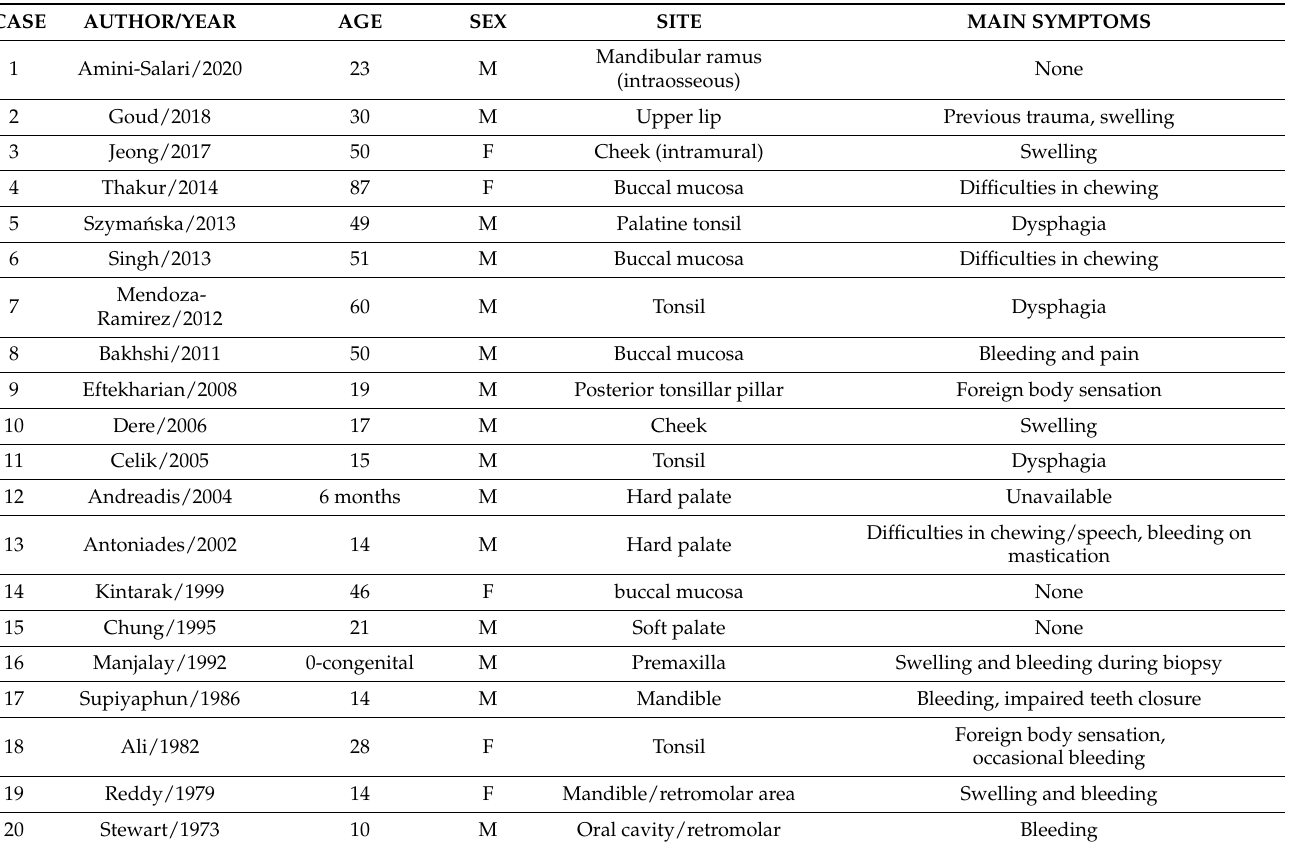
Table 1. Clinical features of extranasopharyngeal angiofibromas (ENAs) of the oral cavity reported in the international literature.